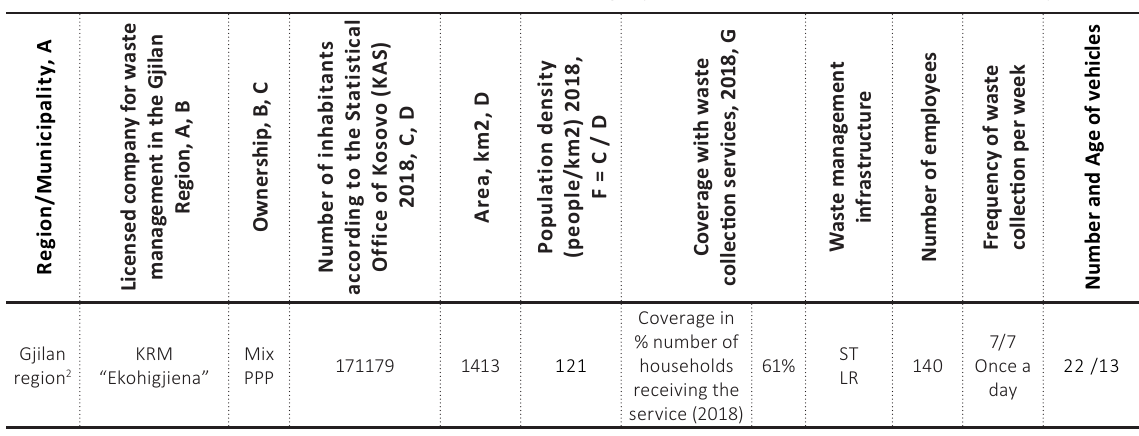
Table 1. Summarizing data on “EcoHigjiena” and its area of